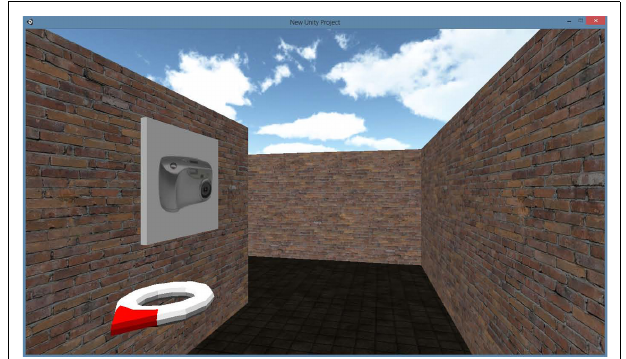
FIGURE 3 | Screenshot from the virtual + condition. This image shows the virtual environment from the participant’s perspective with the directional information provided by the